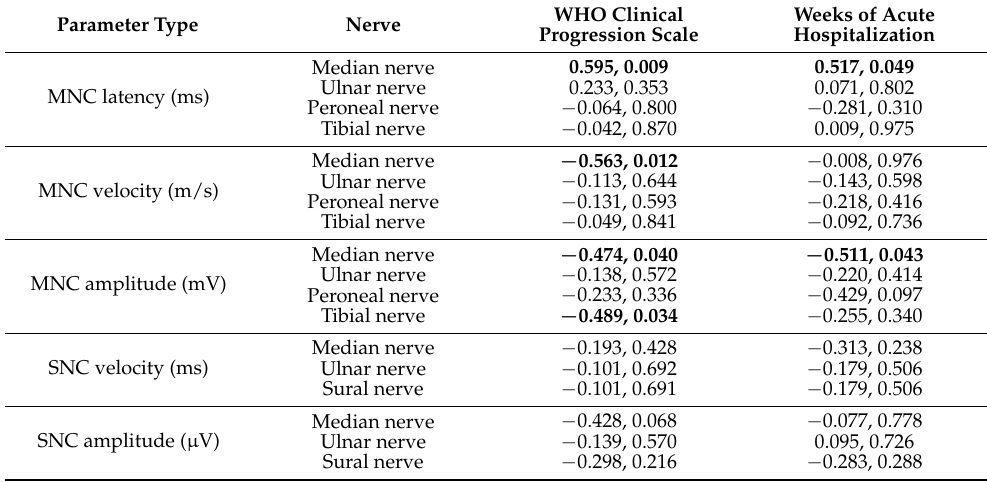
Table 3. Spearman’s correlation coefficient and significance level (r, p) found between the WHO clinical progression scale and the duration of acute hospitalization (in weeks) and Motor Nerve Conduction (MNC) and Sensory Nerve Conduction (SNC) measures. Significant correlation are in bold font.